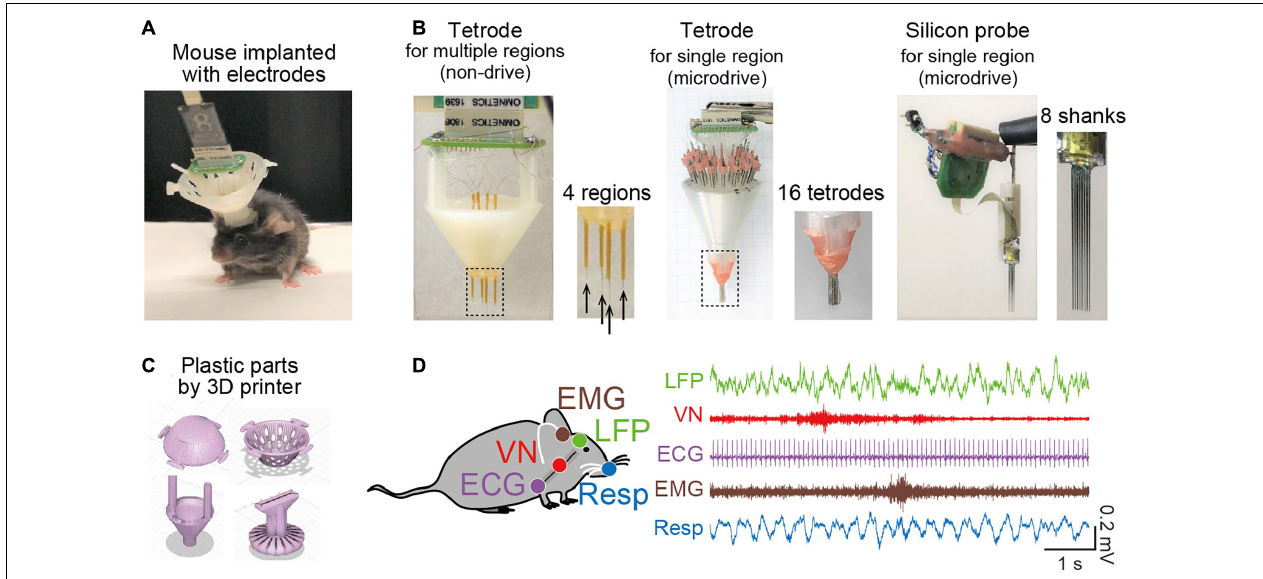
FIGURE 1 | Recent recording methods to study brain oscillations in rodents. (A) A picture of a mouse implanted with an electrode assembly. (B) Typical electrode assemblies with multiple recording sites. (Left) Tetrode arrays to target several separated brain regions. The dotted region is magnified in the right panel, showing the electrode tips (indicated by arrows). (Middle) A microdrive with multiple tetrode arrays to record spike patterns of neurons in a target region. (Right) A microdrive with 8-shanks silicon probes to record spike patterns of neurons in a target region. (C) Typical CAD illustrations of plastic parts created by a 3D printer. (D) Simultaneous electrophysiological recordings of a brain LFP signal, a vagus nerve (VN) signal, an ECG signal, an EMG signal, and a Respiration (Resp) signal.